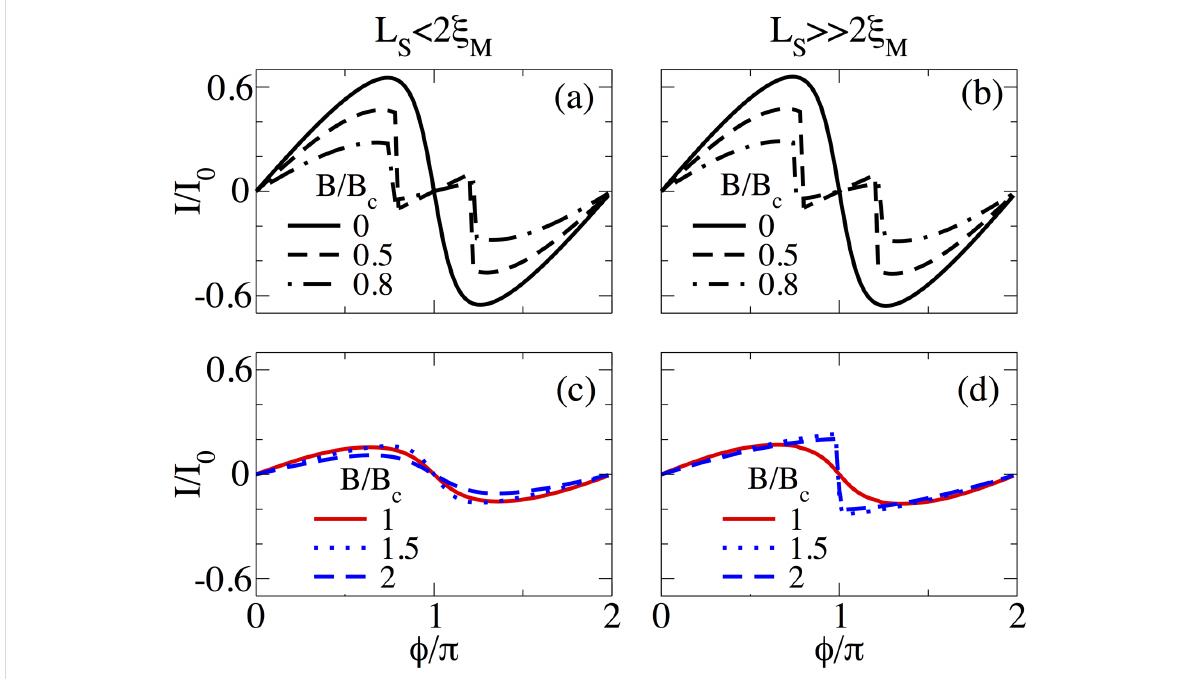
Figure 11: Supercurrent as a function of the superconducting phase difference in a short SNS junction, I ( ), for L S = 2000 nm ≤ 2 ξ M (a,c) and L S = 10000 nm 2 ξ M (b,d). Panels a and b show the Josephson current in the trivial phase for different values of the Zeeman field, B < B c , while panels c and d correspond to different values of the Zeeman field in the topological phase, B ≥ B c . Note the sawtooth feature at = π for